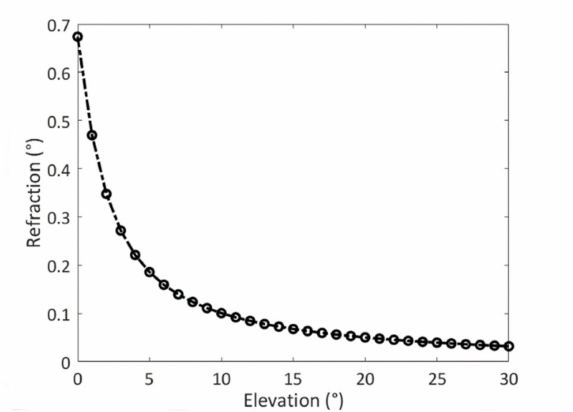
Figure 13. The refraction curve as a function of elevation was calculated by using the refraction model. The interval between data points is fixed (1 ◦ ) on the horizontal